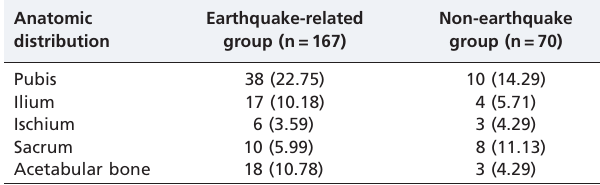
Table 3- Patients with pelvic comminuted fractures according to each pelvic bone